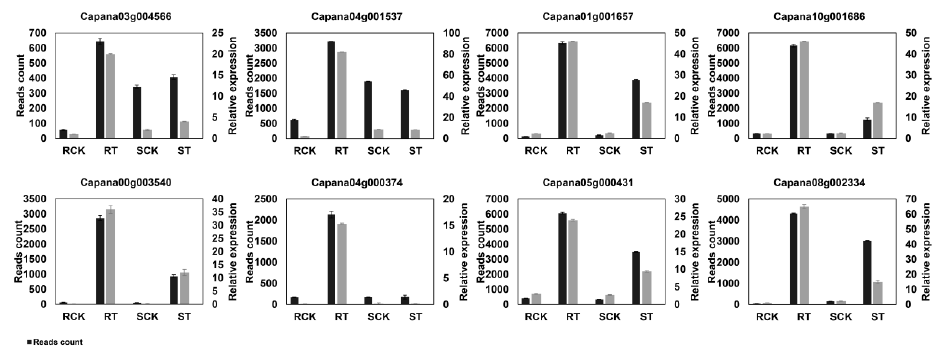
Figure 2. qRT-PCR analyses of eight genes. RCK refers to the control group of the 17CL30, RT refers to the heat treatment group of 17CL30, SCK refers to the control group of 05S180, ST refers to the heat treatment group of 05S180. GST : Capana03g004566 , NAC2 : Capana04g001537 , HSP20 : Capana01g001657 , HSP90 : Capana10g001686 , SLC : Capana00g003540 , WRKY40 : Capana04g000374 , HSP20 : Capana05g000431 , GST : Capana08g002334 .